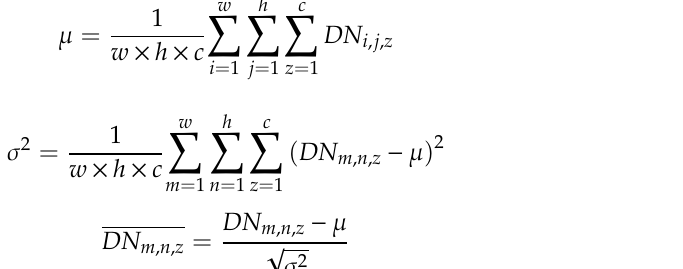
Figure 6. Data augmentation of the three samples. a(2) and a(3) are the results of flipping a(1), b(2) and b(3) are the results of panning b(1), and c(2) and c(3) are the results of zooming c(1).